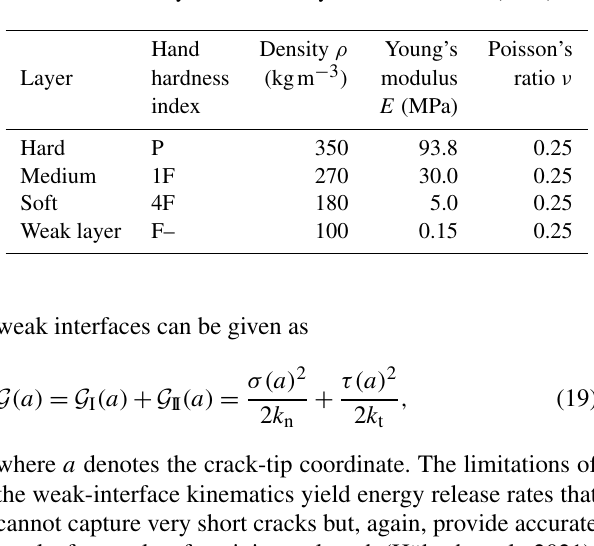
Figure 5. Illustration of benchmark snow profiles used in the present work. Material properties of hard, medium, and soft slab layers (dark) and the weak layer (light) are given in Table 1. The weak layer is 2cm thick and the slab layers have a thickness of 12cm each. Similar profiles were used by, e.g., Habermann et al. (2008) and Monti et al. (2016). Here, we complement the homoge- neous slab H. Table 1. Considered snow layers and their elastic properties with reference to three-layer slabs used by Habermann et al.